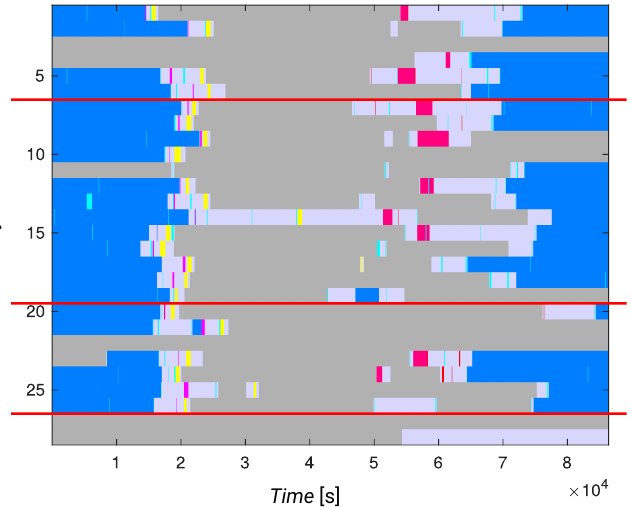
Figure 10. Daily activity representations of the resident in the Kasteren dataset, partitioned according to the clustering results based on sensor